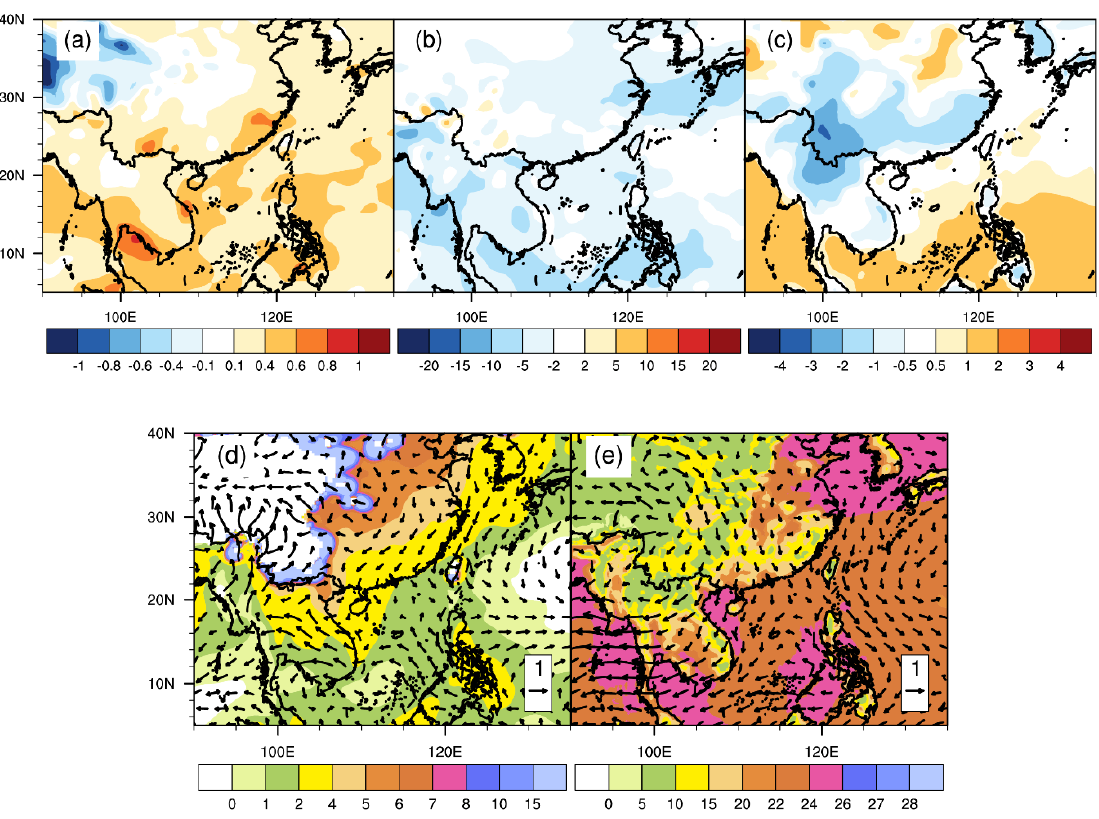
Figure 2. Differences between simulation from CTL test and ERA5 reanalysis datasets averaged from June to August 2015 on ( a ) specific humidity at 700 hPa (unit: 10 −3 kg/kg), ( b ) precipitation rate (unit: mm/day), ( c ) temperature at 2 m (unit: K), ( d ) the geopotential height (contour; unit: gpm) and wind (vector; unit: m/s) at 850 hPa, and ( e ) 500 hPa.